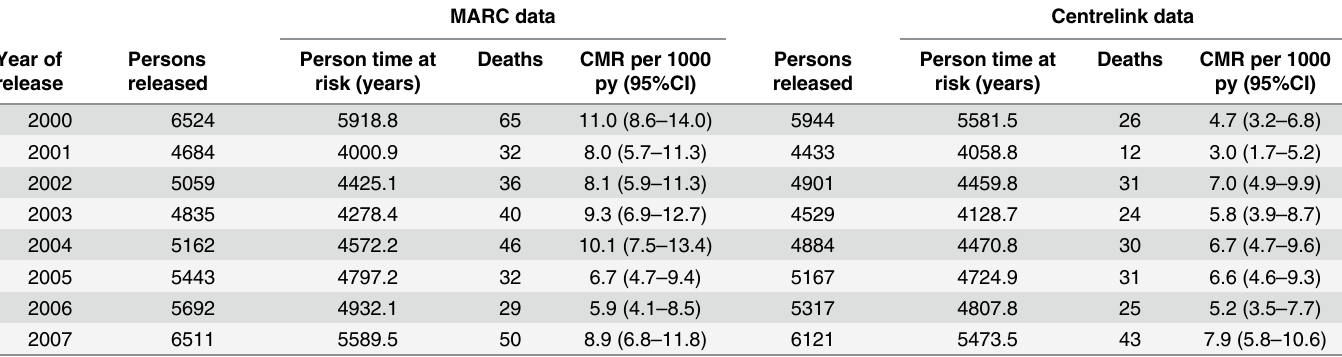
Table 2. Estimated number of releases, deaths and CMR within 365 days of release, among adults released from prison in Queensland 2000 – 2007, according to data